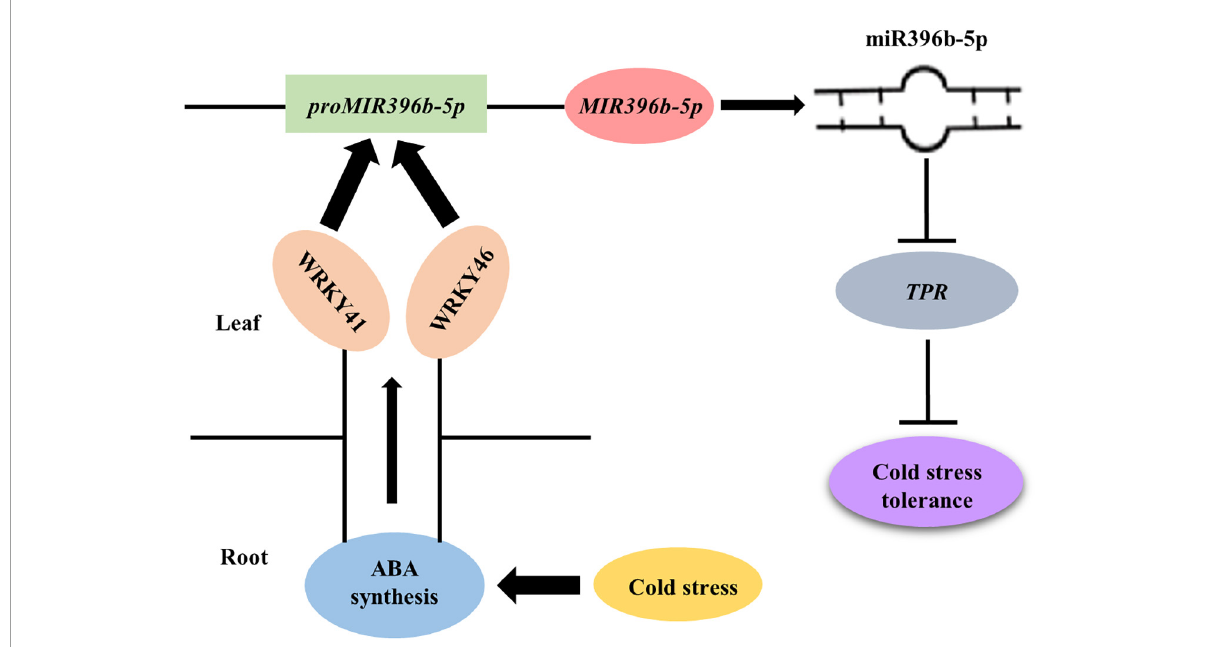
FIGURE8 A proposed model for the molecular regulatory pathway of cucumber seedling grafted onto figleaf gourd rootstocks. When grafted cucumber seedling exposed to cold stress, ABA accumulated in roots and leaves, which induced the expression of WRKY41 and WRKY46 . Then, WRKY41 and WRKY46 bound to the promoter of MIR396b-5p to activate its transcription to form mature miR396b-5p. miR396b-5p negatively regulated the target gene TPR via direct cleavage, resulting in improving the cold tolerance of grafted